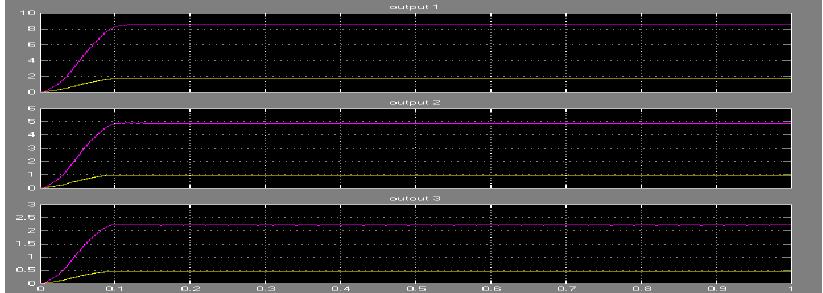
Fig. 17. Simulink results for output voltages and